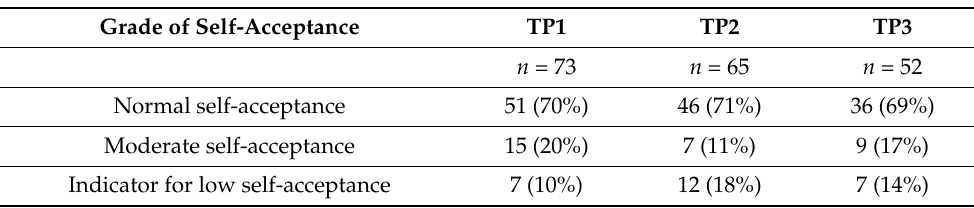
Table 13. Frequencies of the indicators of the SESA total score. Grade of Self-Acceptance TP1 Normal self-acceptance Moderate self-acceptance Indicator for low self-acceptance 7 (10%)